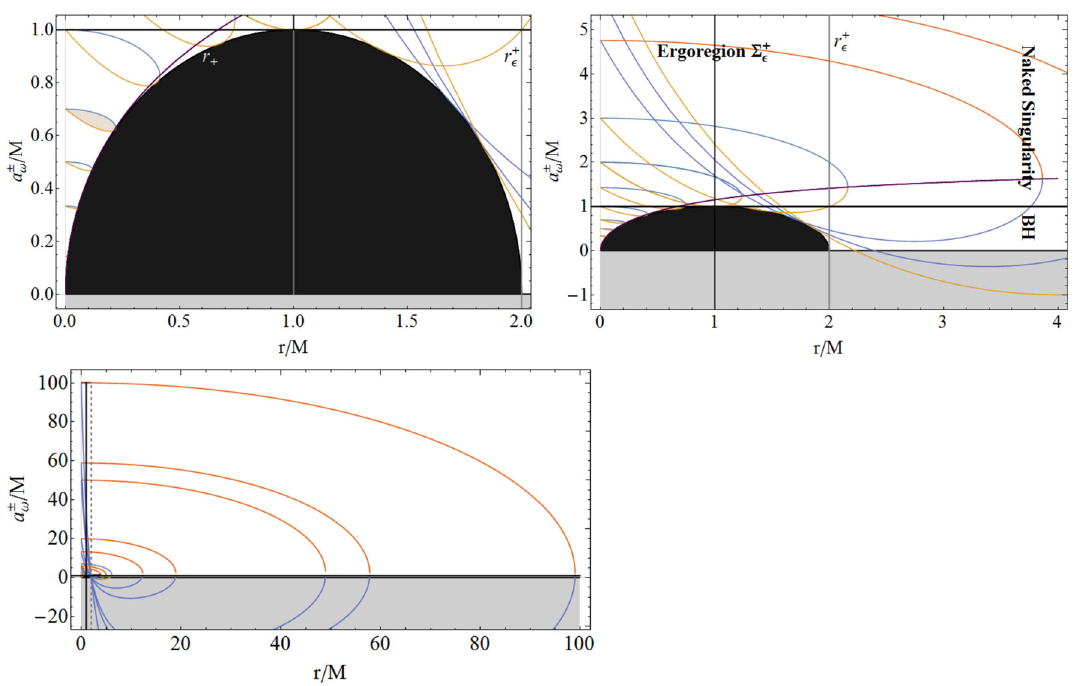
Fig. 8 Spins a ± ω versus r / M for different frequencies. The black region is for r < r + and r + is the BH outer horizon. See also Fig. 9 for a 3 D representations of these regions